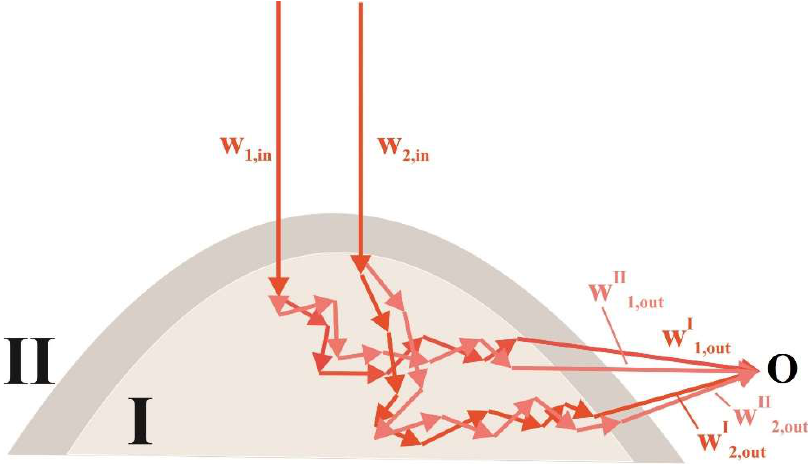
Figure 9. The schematic sketch illustrating the considered semi-quantitative model. The current value of the intensity at the observation point O is the result of the interference of a large number of statistically independent partial waves propagating along random trajectories in the foam volume. Figure 9 schematically represents a pair of such waves ( w 1 , w 2 ) undergoing random phase shifts due to sequences of scattering events and interfering at the point O. These waves arriving at the observation point are associated with an ensemble of random phasors similar to that considered in the numerical model in Section 2.2. During the transition of the foam from state I to state II in the course of expansion, each phasor corresponding to a partial wave acquires a phase shift N sc , i ∆ ϕ ∆ ϕ s ∑ = due to microscopic structural rearrangements in the foam volume. Here, i i s ∆ ϕ s is the local phase shift associated with s -th single scattering event in the sequence, and N sc , i is the total number of scattering events for a considered partial wave. Based statistical independence of the local phase shifts ∆ ϕ s with a zero ensemble-averaged value i (cid:68) (cid:69) ∆ ϕ s = 0 (the upper line denotes averaging over the sequence of scattering events for i i